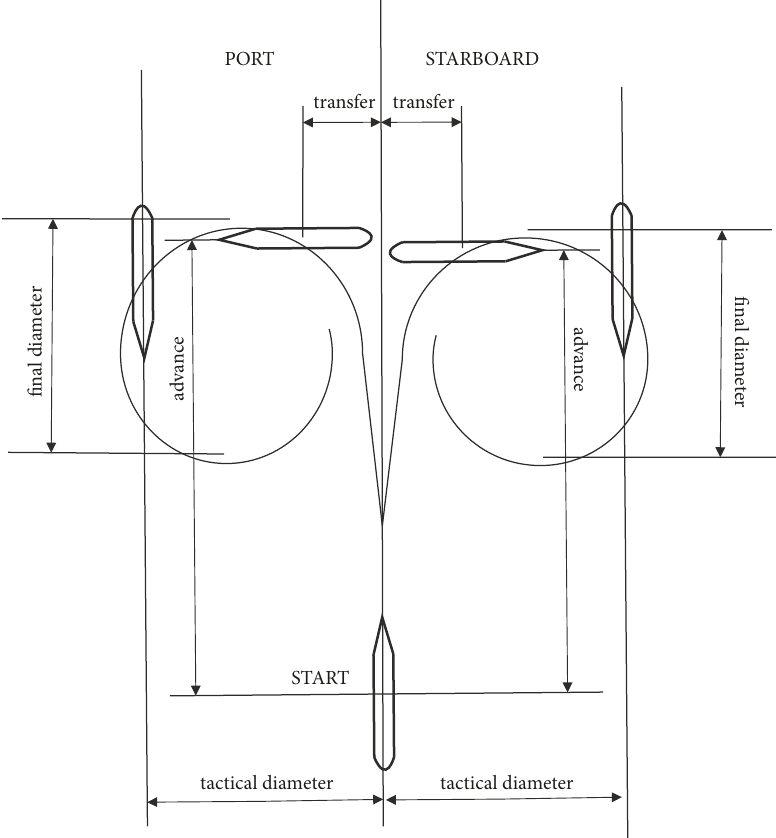
Figure 3: Typical graphical presentation of ship manoeuvrability characteristics available on board in the form of a wheelhouse poster (the sketch taken from didactical materials for students of the Faculty of Navigation, Gdynia Maritime University).